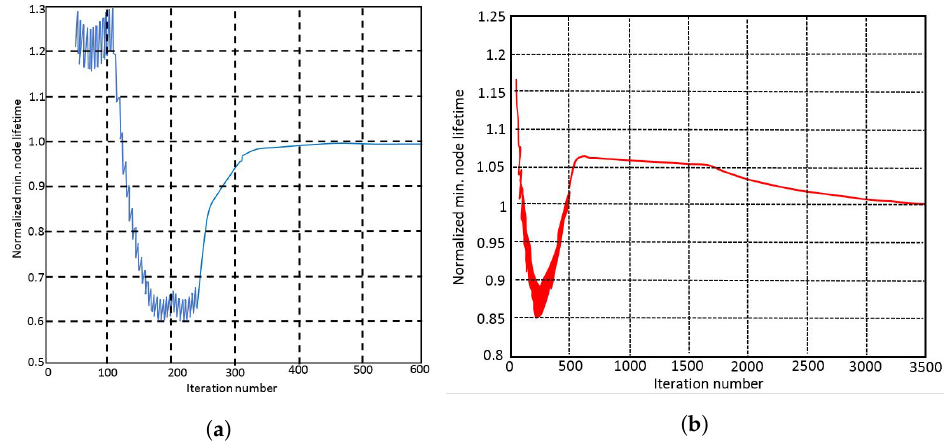
Figure 12. Number of subgradient iterations needed for convergence by the partial and fully distributed schemes proposed in [2]. ( a ) Partially distributed scheme; ( b ) Full distributed